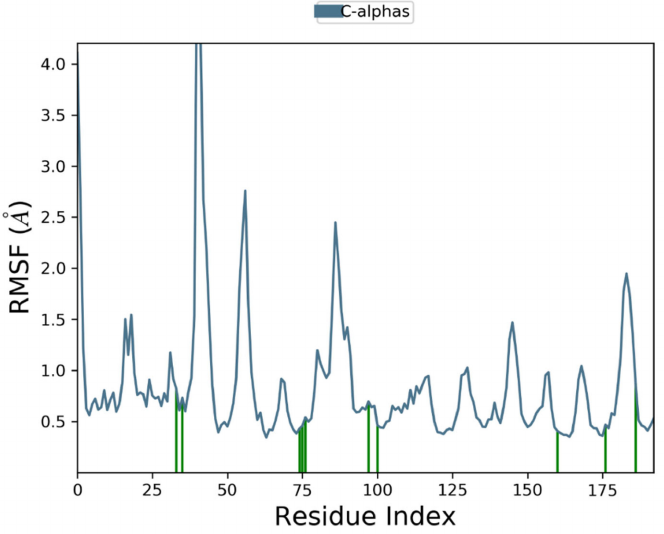
Figure 9. Root Mean Square Fluctuation plot of Comp2 and NS2B-NS3 complex of ZIKV.